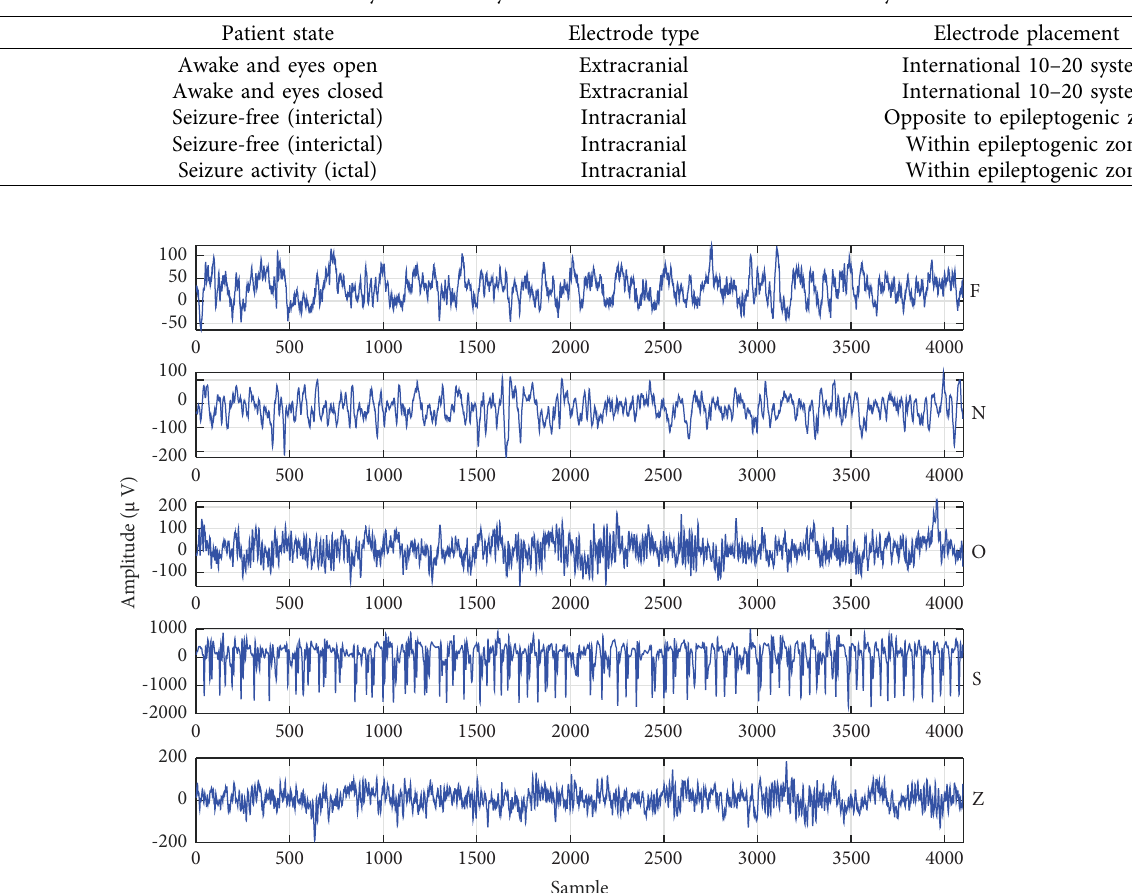
Table 1: Summary of University of Bonn EEG database used in this study.